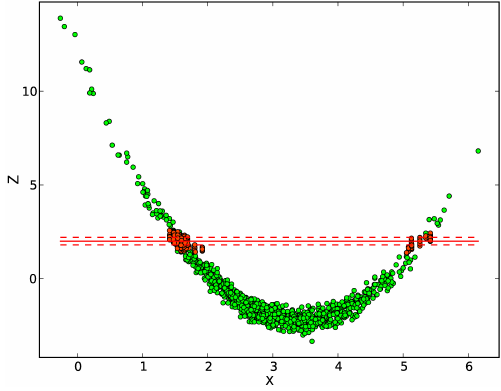
Figure 7. Same as Fig. 4, right panel, but for the